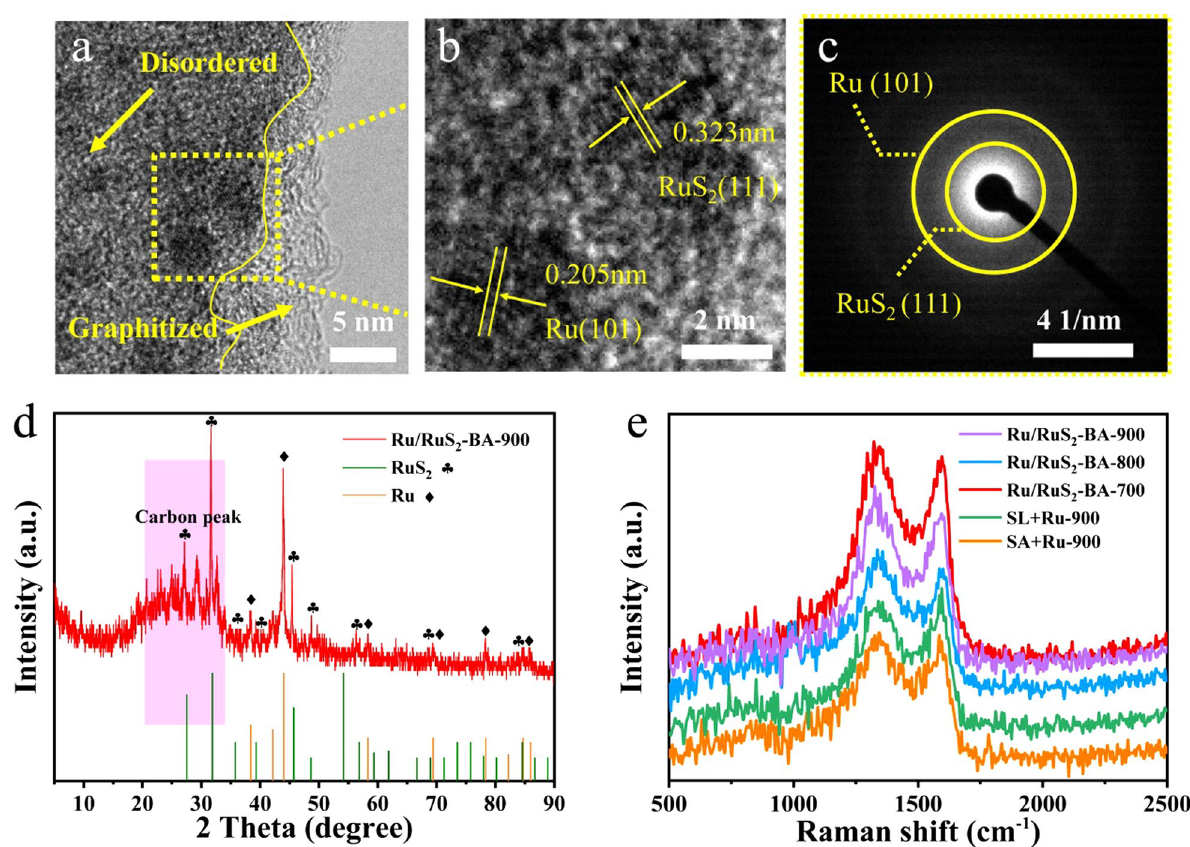
Fig. 3 a , b HRTEM images of Ru/RuS 2 -BA-900. c Selected area electron diffraction (SAED) of Ru/RuS 2 -BA-900. d XRD patterns of Ru/RuS 2 - BA-900, e Raman spectra of SL + Ru-900, SA + Ru-900, and Ru/RuS 2 -BAs prepared at 700, 800, and 900